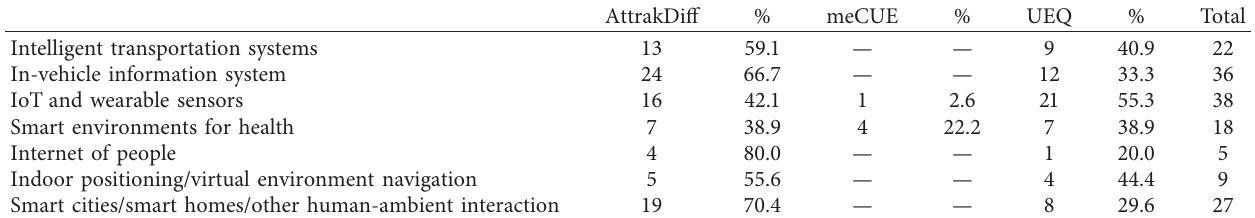
Table 7: Percentage of standardized questionnaires for UbiComp and ambient intelligence studies by topic.